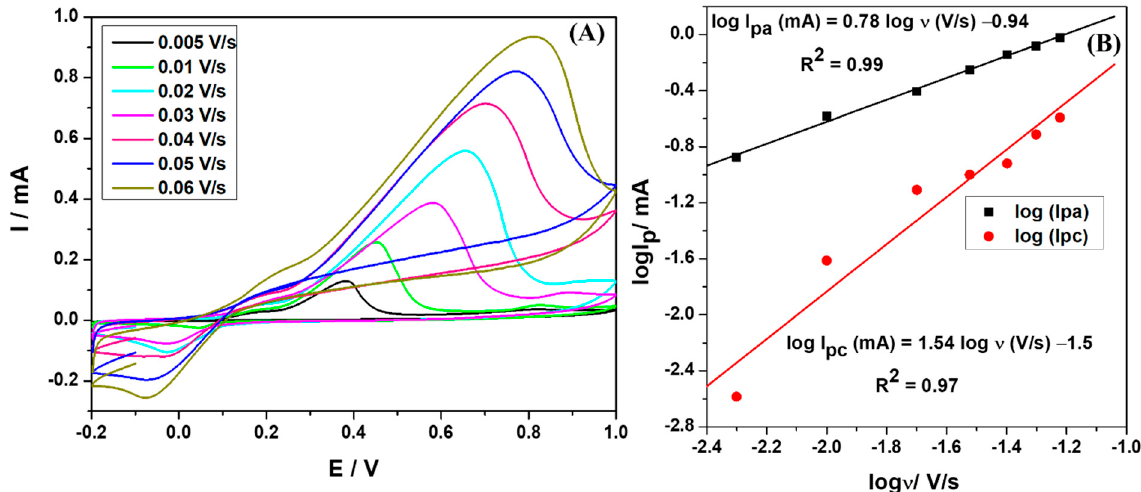
Figure 6. ( A ) Cyclic voltammograms of the SPCE/CuS-2 at different scan rates (0.005 to 0.06 V/s) in 0.01 M phosphate buffer solution of pH 7.4 containing 3 mM of glucose. ( B ) Dependence of the logarithm of redox currents with the logarithm of scan rates.